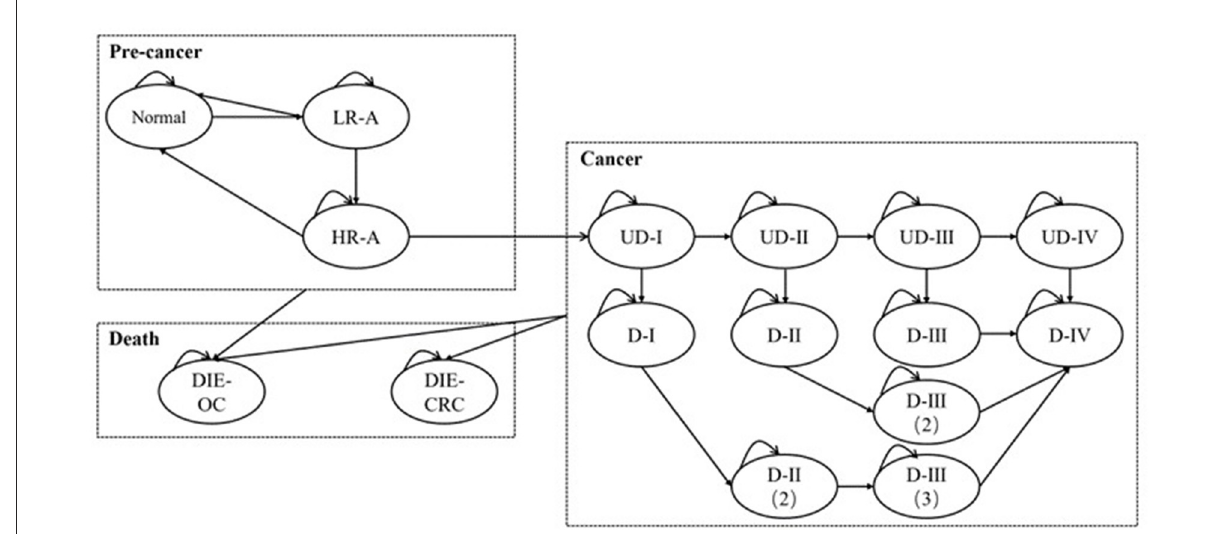
FIGURE2 The Markov model for analysis in scenario 3. L/HR-A, low/high-risk adenoma; (U)D-I/II/III/IV, (undiagnosed) cancer at stage I/II/III/IV; DIE-CRC: die of colorectal cancer; DIE-OC, die due to other